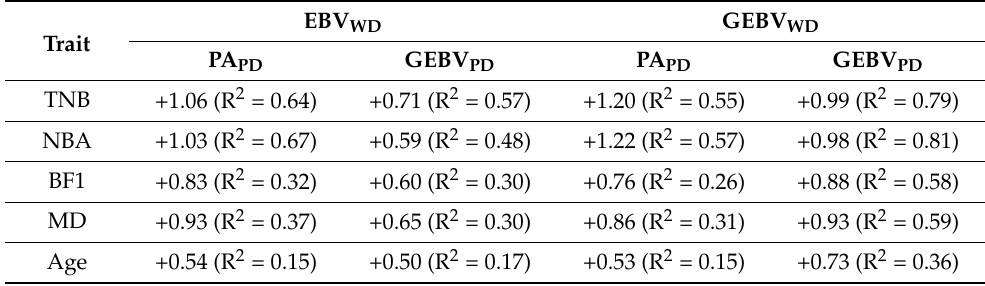
Table 5. Regression coefficients (b) of final estimates ( EBV WD, GEBV WD ) on predictions ( PA PD, GEBV PD ) of validated ani- mals. Trait